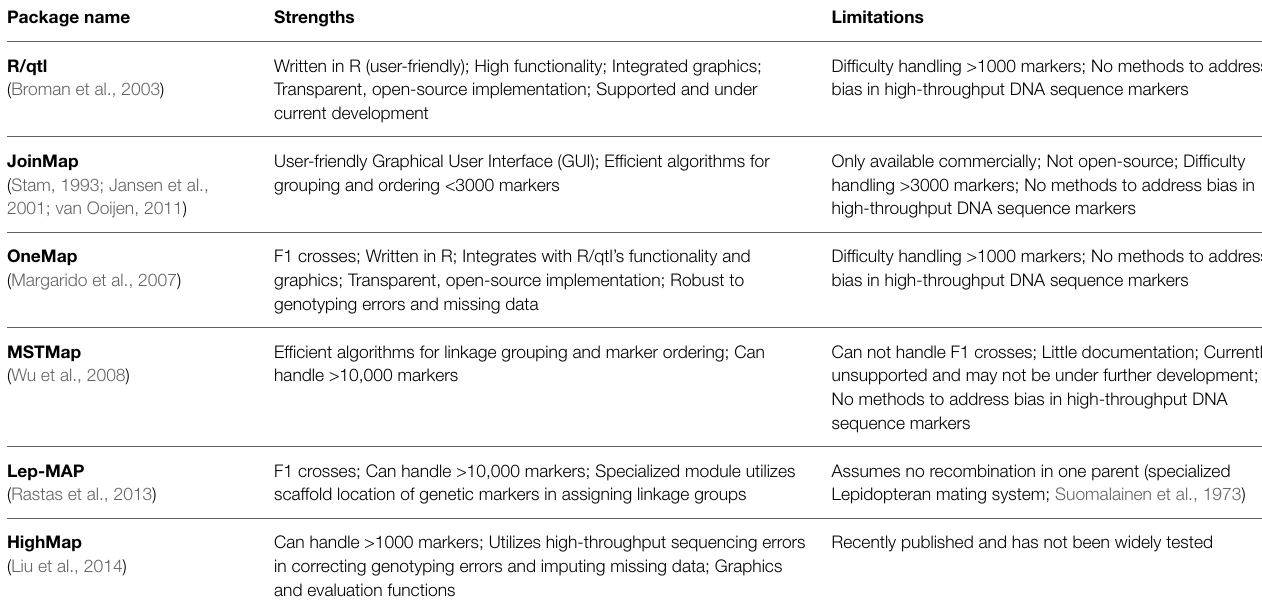
TABLE 1 | Software packages for estimating genetic linkage